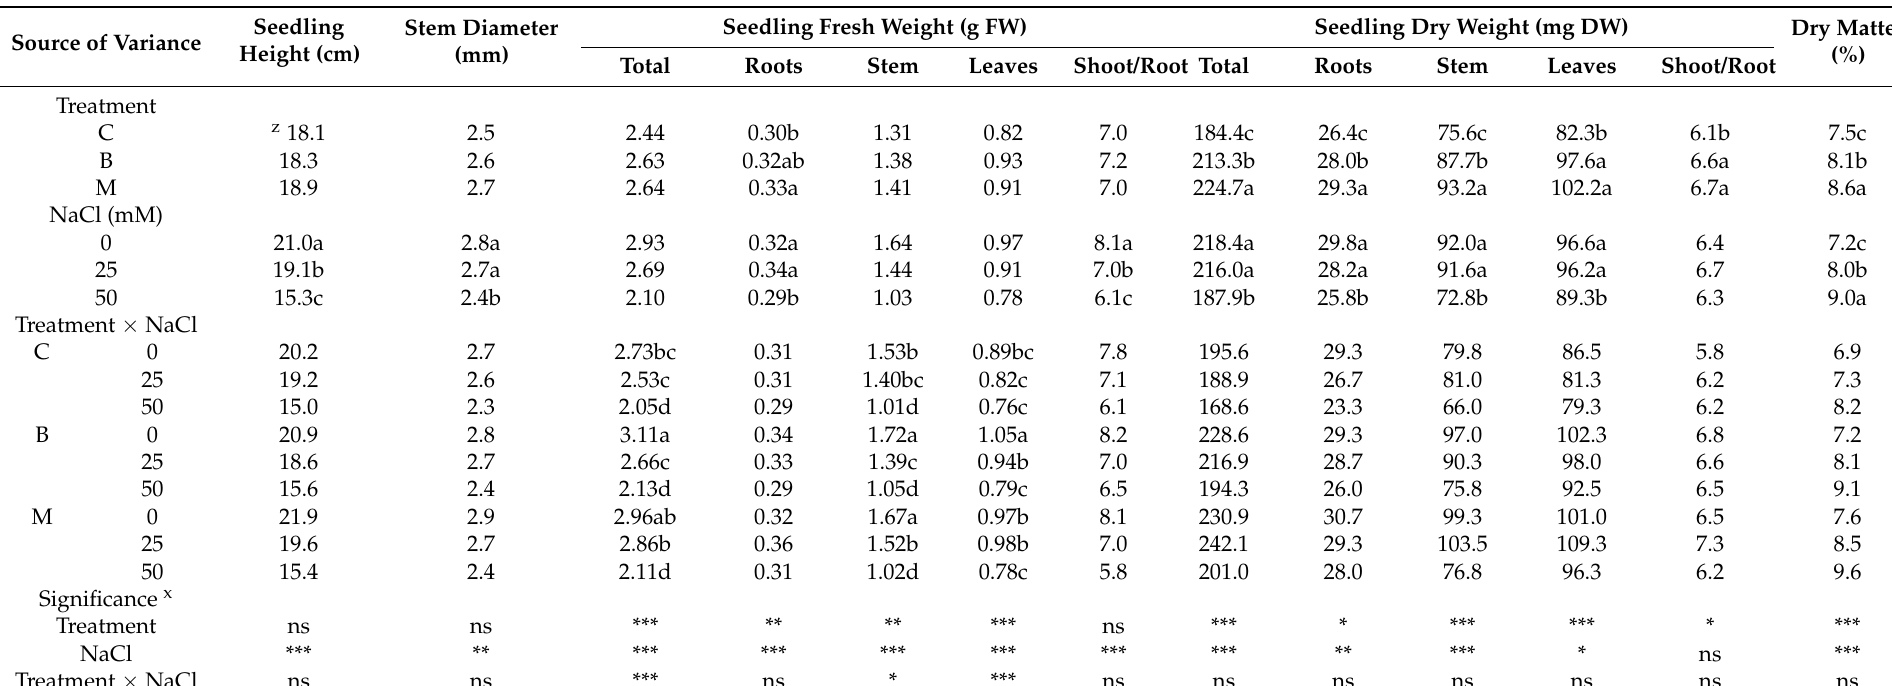
Table 3. Effects of microbial biostimulant treatment (C, not treated; B, Bactorr S13 ; M, Flortis Micorrize) and salt stress (0, 25, and 50 mM NaCl in the irrigation water) on morphological parameters of tomato